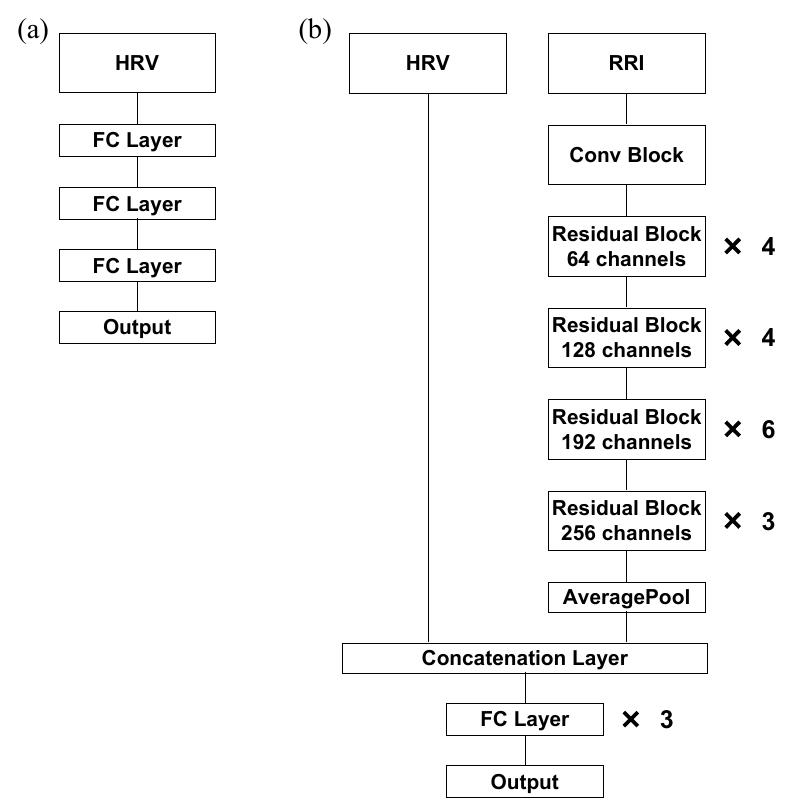
Figure 4. Overall architecture of ( a ) HRV model; ( b ) combined model.